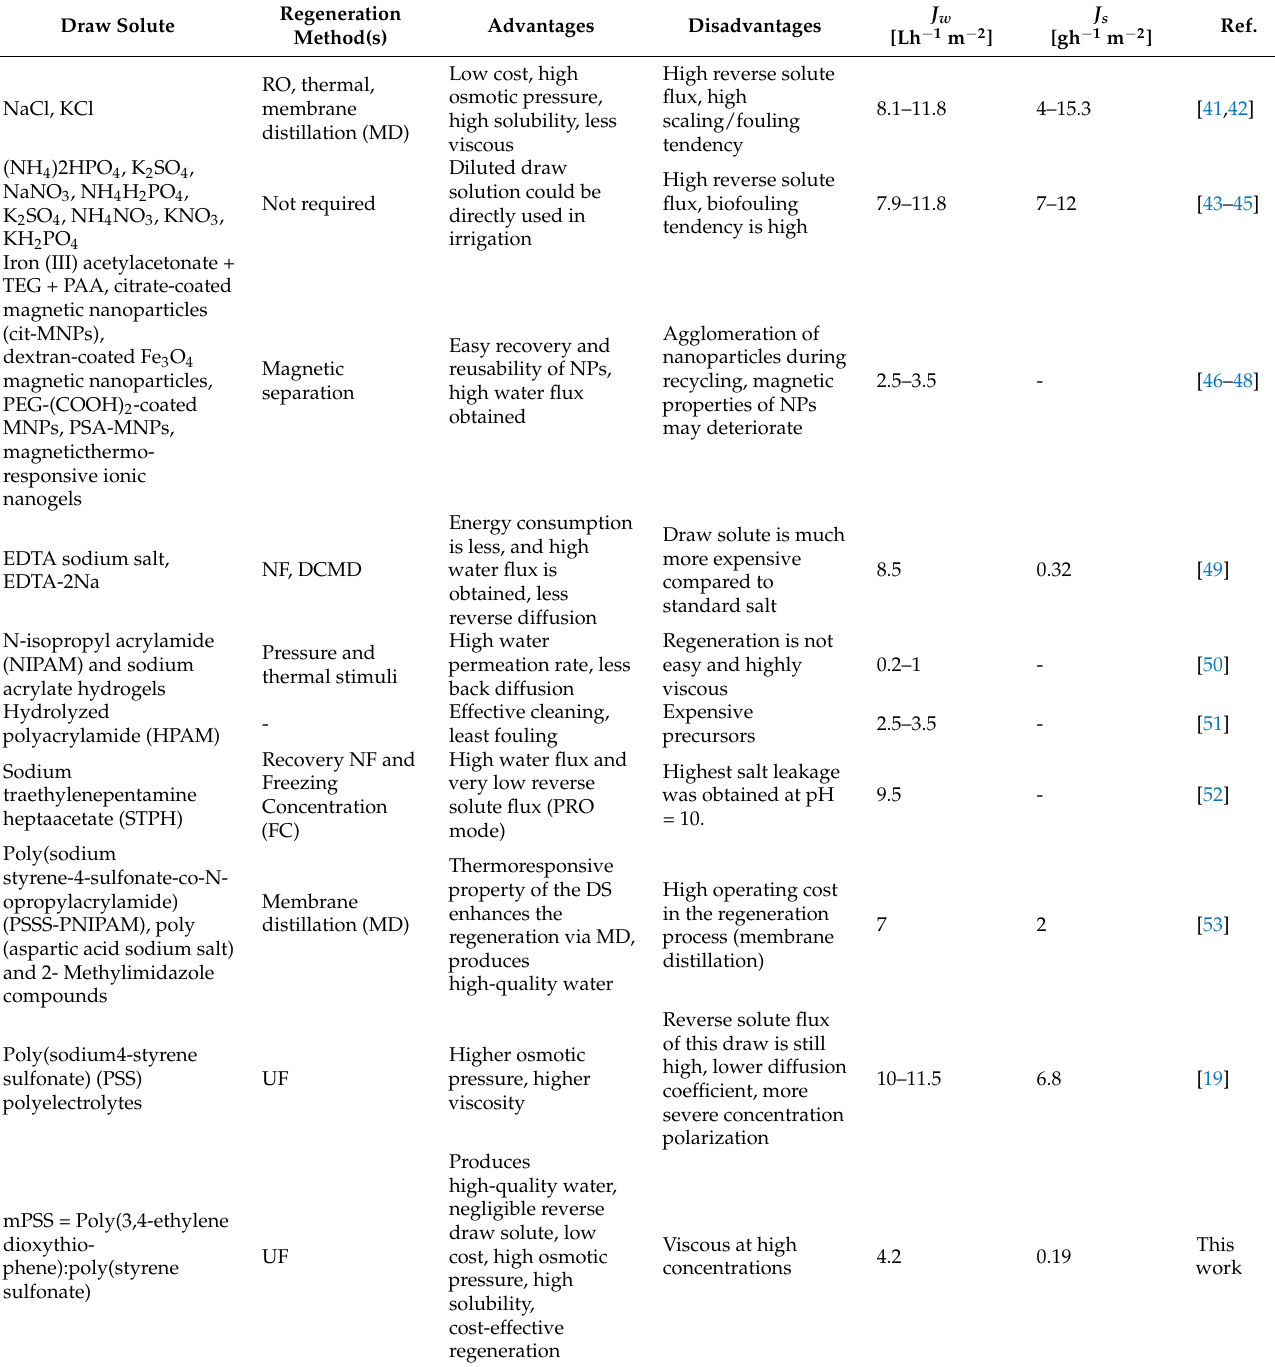
Table 2. Overview of draw solutes their recovery methods, advantages, disadvantages and FO